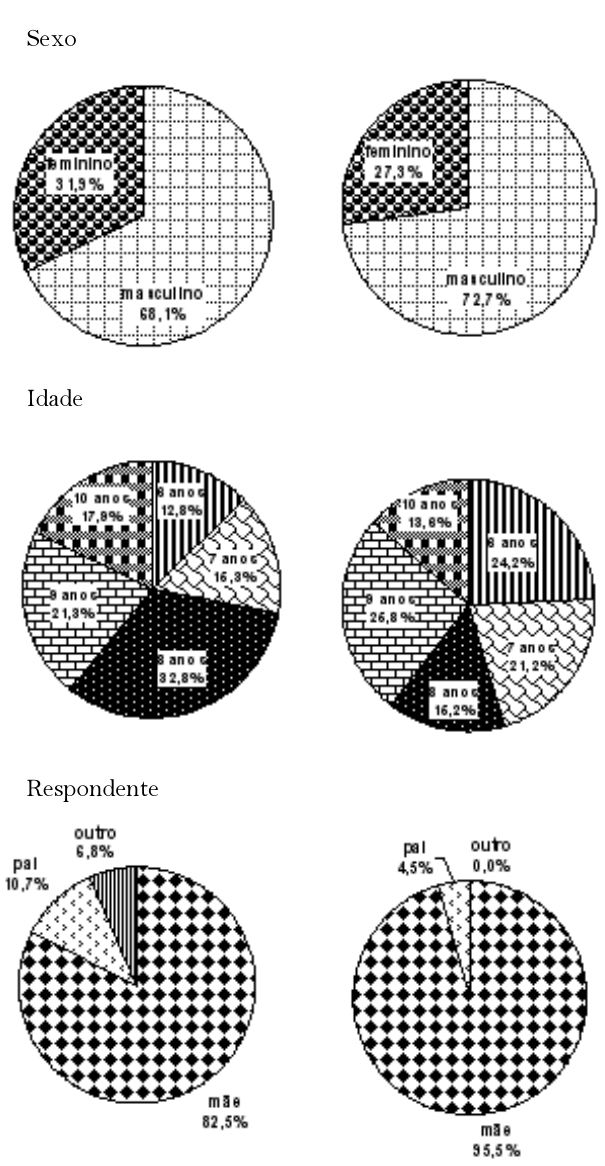
Figura 1. Distribuição por sexo, idade e respondente nos grupos triagem (n = 235) e enurese (n =